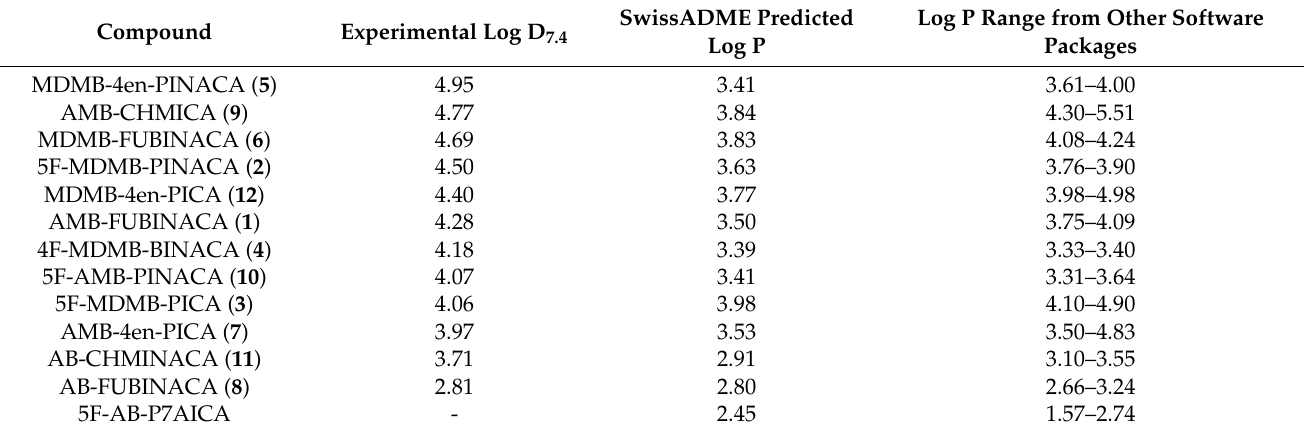
Table 1. Predicted Log P and experimentally derived Log D 7.4 values for test SCRAs calculated using a chromatographic hydrophobicity index (CHI). SwissADME data are shown, with log P ranges obtained using Gastroplus, MoKa, Canvas and XlogP software provided for comparison (see Section S2 of the supplementary information for full data set). Data for